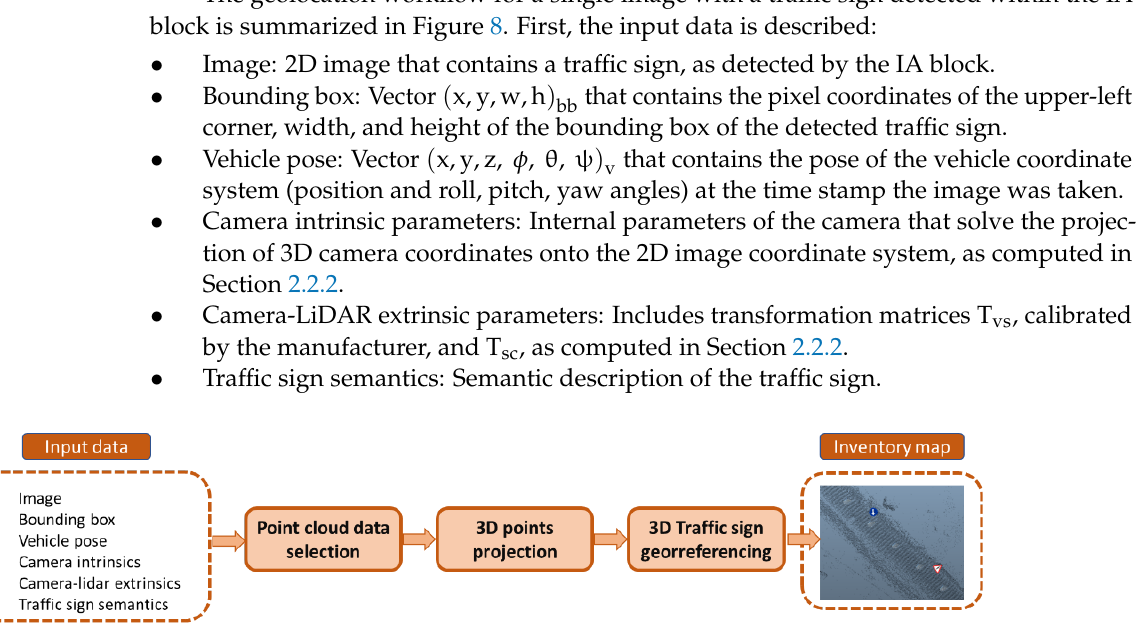
Figure 8. Geolocation workflow for a single image with a traffic sign detected within the Deep Learning block.